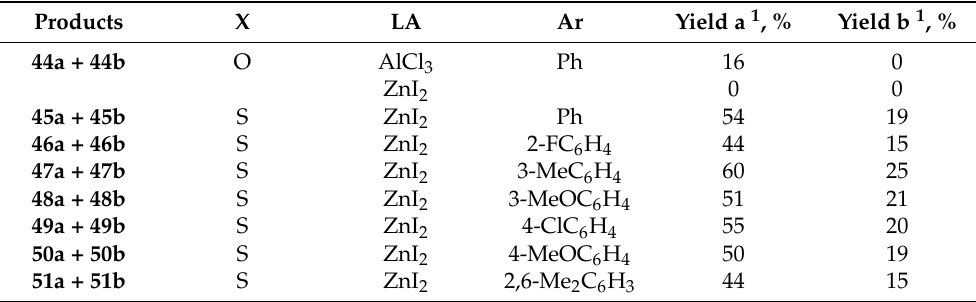
Table 2. Diels–Alder reactions of 5-methylideimidazolones with cyclohexadiene.